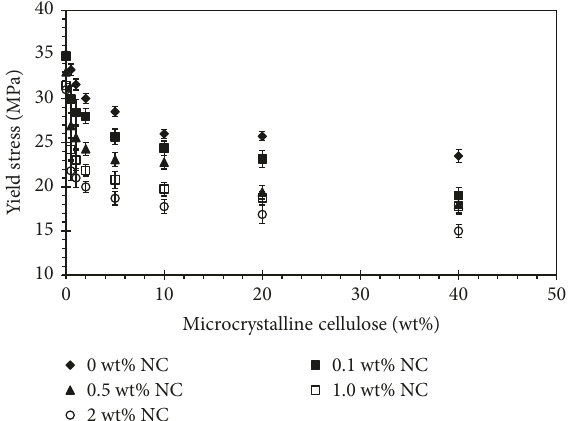
Figure15:ImpactstrengthPP/MCCcompositesasafunctionofNC